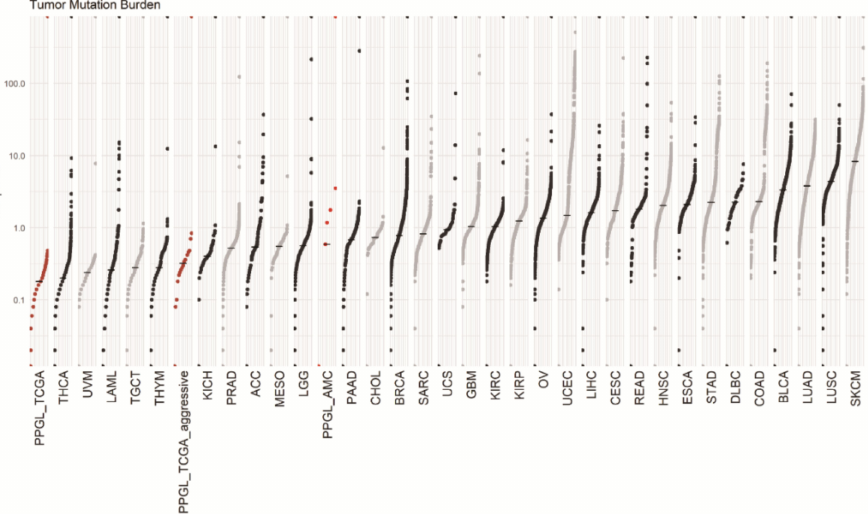
Figure 4. The tumor mutation burden (TMB) of metastatic pheochromocytoma and paraganglioma (PPGL) of AMC was 0.58. That of TCGA non-aggressive and aggressive tumor was 0.18 and 0.32 respectively. Data source: https://gdc.cancer.gov/about-data/publications/mc3-2017, accessed on 28 July 2020. Abbreviations for tumors and median TMB are summarized in Supplementary Table